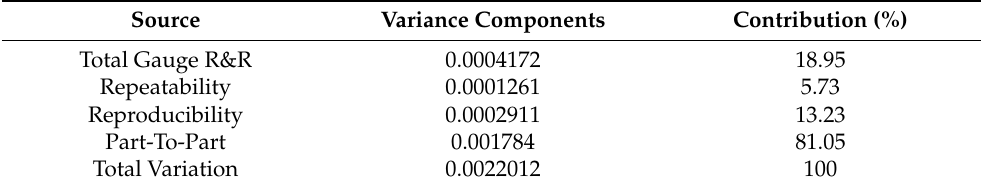
Table 6. Gauge R&R test